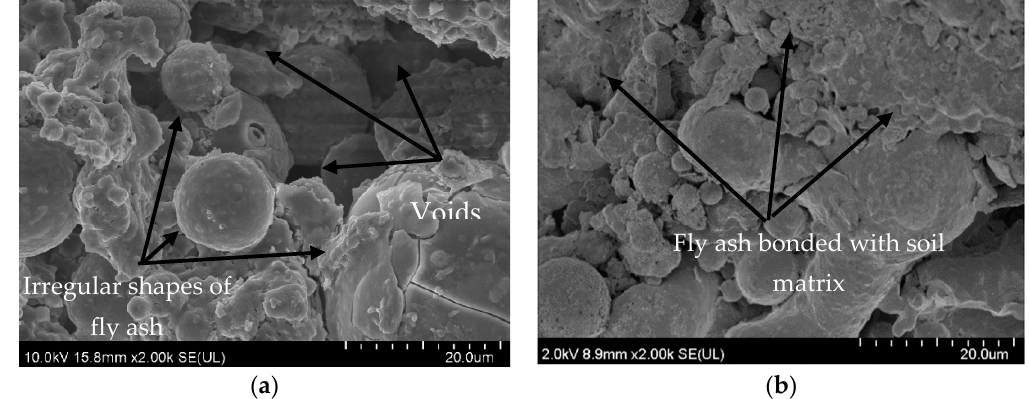
Figure 8. FESEM images for treated soil with inclusion of fibre (CFAF).